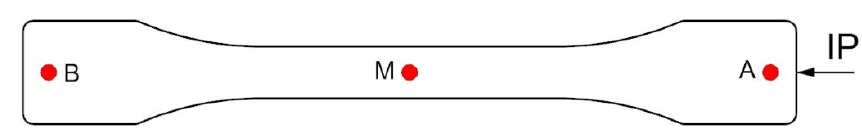
Figure 1. Scheme of sample measurement with marked points where microscopic observations as well as color and gloss measurements were carried out: IP — injection point; A — gate side; M — middle; B — opposite side of the gate.